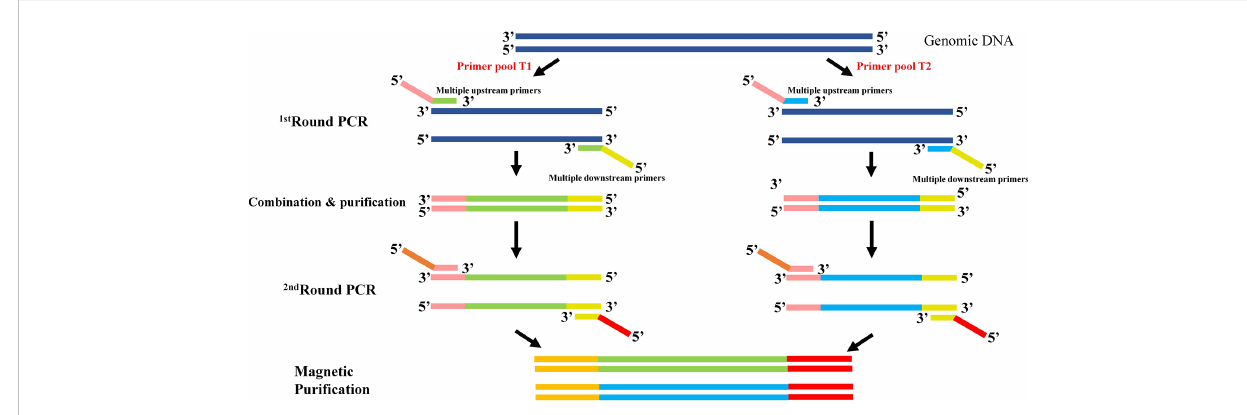
FIGURE 1 Schematic diagram of the multiplex PCR amplicon sequencing method for CYP2C9 genotyping. Two rounds of PCR ampli fi cation were included in this method. The fi rst round of PCR is for the multiplex ampli fi cation of all 9 exons of CYP2C9 gene with pooled primers T1 or T2. After the combination and puri fi cation with magnetic beads, products were used as the template for the second round of PCR reaction and sequencing library construction. Universal primers in round 1 are illustrated as pink and yellow bars, and sequencing primers in round 2 are shown in brown and red